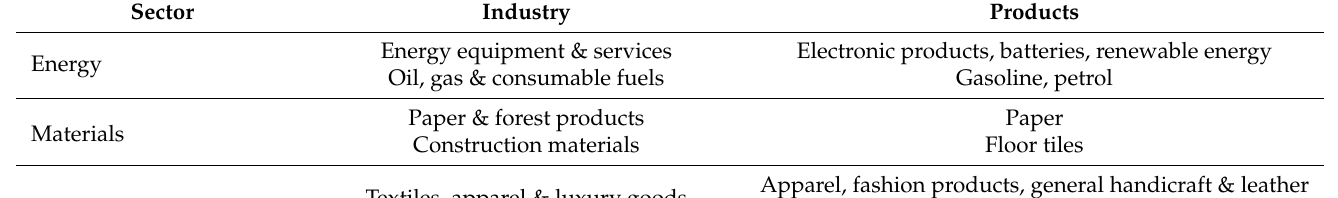
Figure 3. Countries of research locations (the colors indicate the intensity of studies). Table 2. The researched products (classification based on The Global Industry Classification Stand ‐ ard).